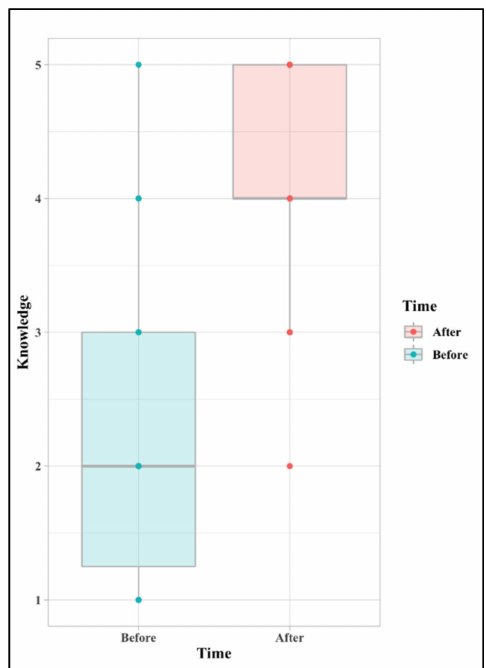
Figure 7. Paired t -test for knowledge change before and after participation.